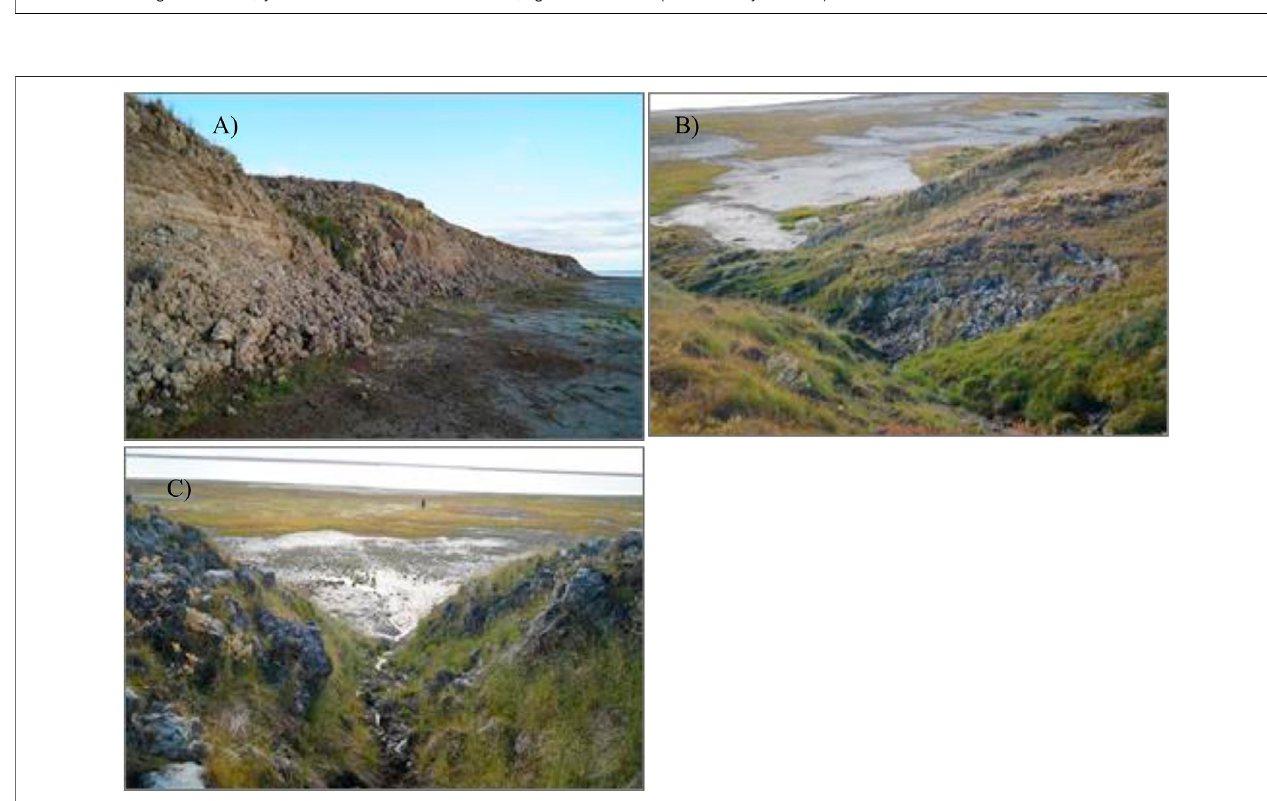
FIGURE 12 | Field campaign August 2018. (A) Sedimentation layer showing lake level in the past compared to present lake level. (B) Erosion, instability of the slopes, landslides within unconsolidated sediment layers. (C) Gullies showing seasonal incision due to permafrost melt in the study area (Photos: Anton Sinitskiy).